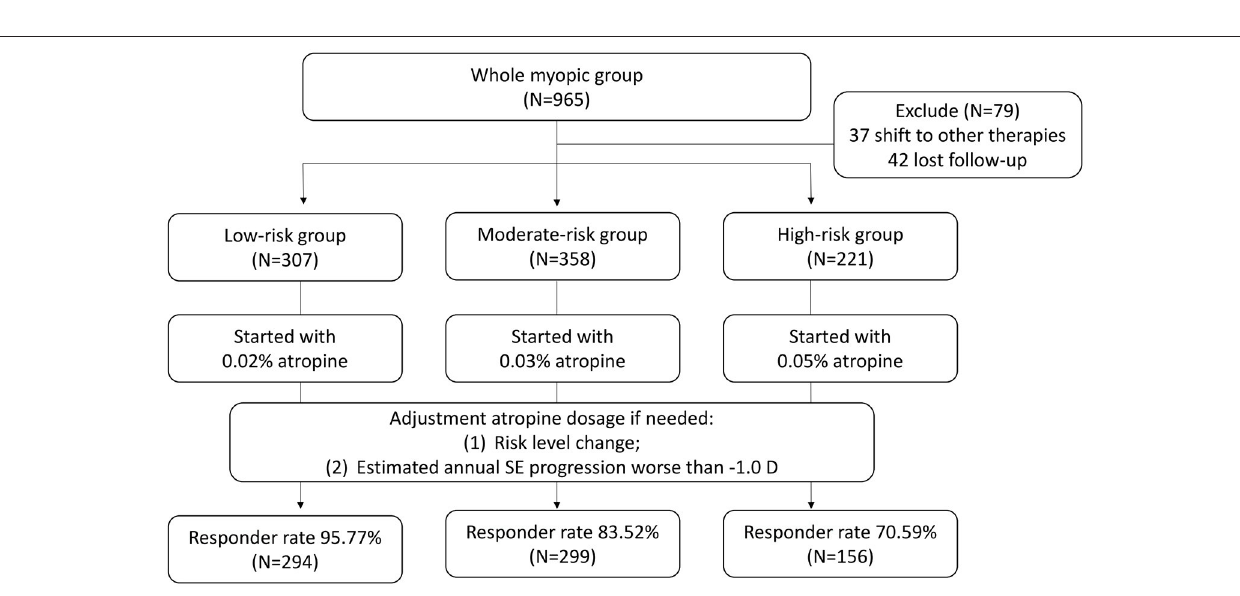
FIGURE 2 | The study protocol of the second part of the study. The atropine concentration for starting treatment was individualized based on the patient’s risk classification from the growth chart derived from the first part of this study from 0.02, 0.03, and 0.05%, respectively. SE, spherical